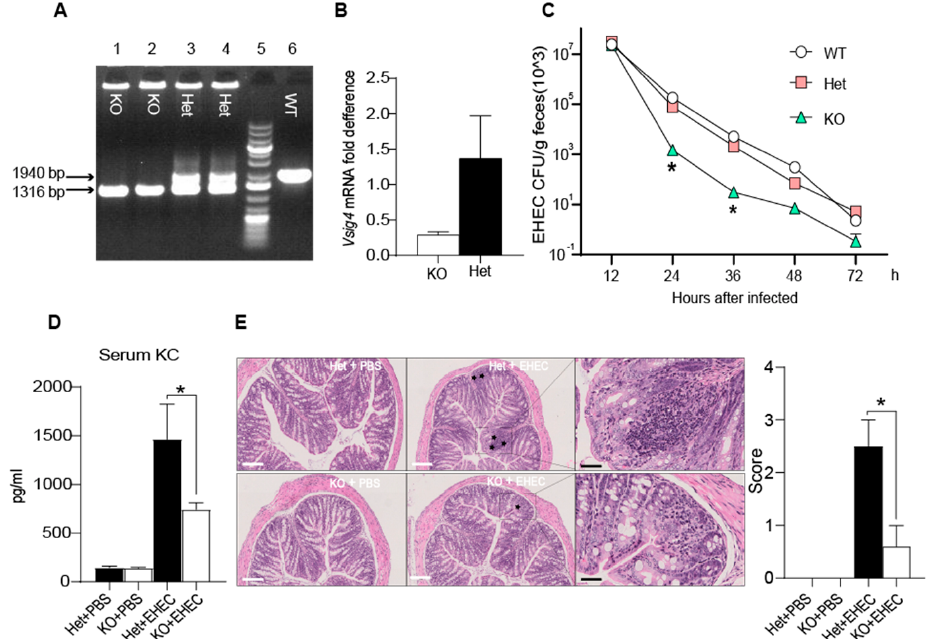
Figure 1. EHEC showed lower colonization in Vsig4 − / − mice. ( A ) Verification of Vsig4 gene deletion. The tails of WT ( Vsig4 +/+ ), Het ( Vsig4 + / − ) and KO ( Vsig4 − / − ) mice were collected and used as templates for PCR fragment amplification after lysis. The WT (lane 6) has a band size of 1940 bp, while the KO (lane 1, 2) was 1316 bp. And the Het (lane 3, 4) has both bands. ( B ) The total RNA of lung tissue was extracted and used as a template for RT-PCR amplification to verify the mRNA level of Vsig4. Het mice were used as a positive control. ( C ) EHEC infected the mice at a dose of 1 × 10 9 . The EHEC excretion in feces at different time points was detected. ( D ) At 36 h of infection, mice serums were collected and ELISA detected K.C. (IL-8) levels. PBS treated mice served as a control. ( E ) The colons of mice treated at 36 h in each group were sectioned, fixed, and stained. Inflammatory cells (star) were marked ( left ). White bars represent 200 µ m, and black bars represent 50 µ m. Right is the colon injury severity score. The degree of colonic pathological injury ranged from the slightest to the most severe, with a score of 0–10. Three to five fields of vision were selected for each slide t -test, * p < 0.05, error bars represent SEM. All the above experiments were repeated more than twice. WT: Wild Type; KO: Knockout; Het: Heterozygote; EHEC: Enterohemorrhagic Escherichia coli ; K.C.: keratinocyte-derived